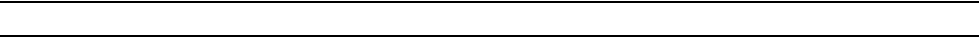
Algorithm 2: Cooperative adjustment algorithm between normal nodes and camera